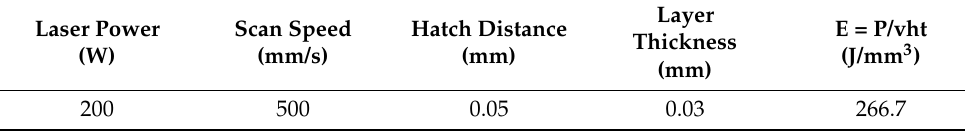
Table 1. Summary of the 3D printing parameters used in this study.